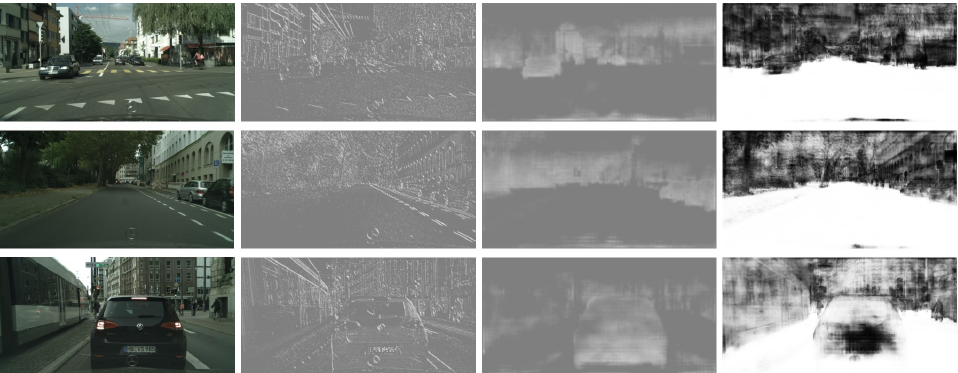
Figure 1. Visualization examples of features in different stages of the concatenation process on the Cityscapes dataset [19]. From left to right are input images, low-level features, deep-level features, and features after concatenation